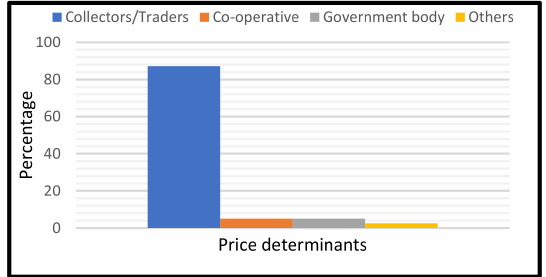
Figure 19. Major players determining the price of